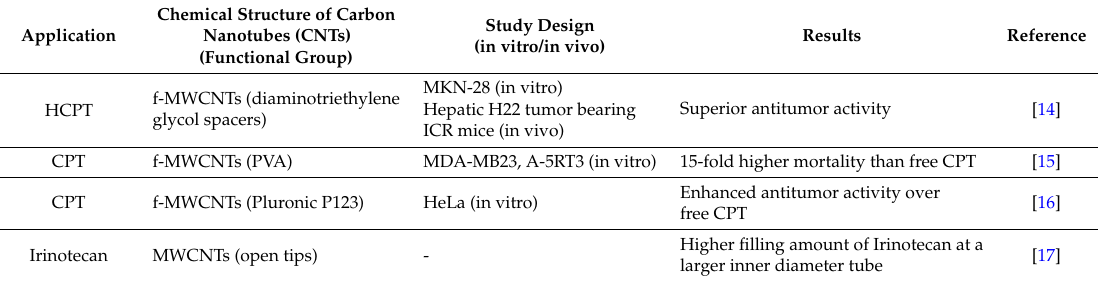
Figure 1. Schematics of a single-walled carbon nanotube (SWCNT) and multi-walled carbon nanotube (MWCNT) (center), and various functionalizations/applications of CNTs for cancer therapy. Table 1. Applications of functionalized carbon nanotubes for the therapy and diagnosis of cancer in this review.